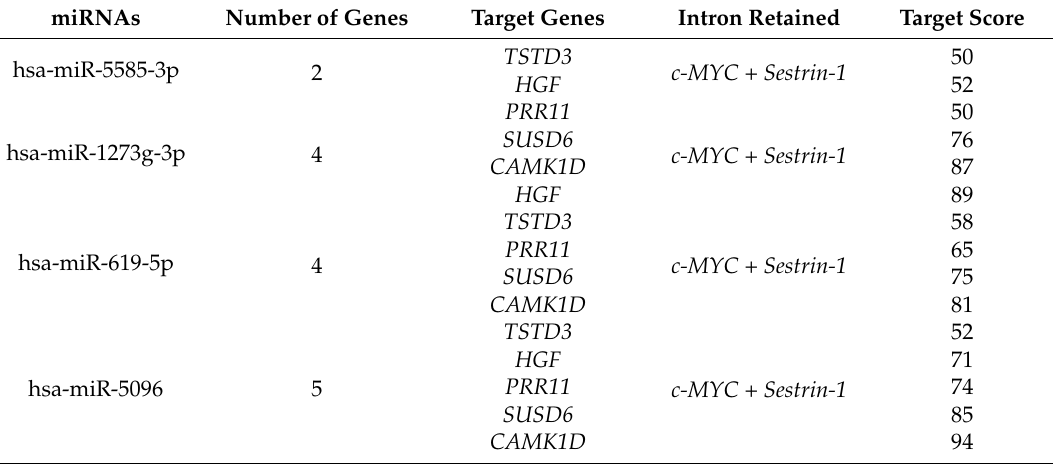
Table 1. Collection of miRNA species that are likely produced by both c-MYC (2/3) and Sestrin-1 (9/10) retained introns, and can simultaneously downregulate the same group of target transcripts. Name of human miRNA molecule, number of miRNA target genes (transcripts), name (symbol) of target gene, name (symbol) of gene undergoing intron retention, and target score (success level of miRNA complementary binding to target transcript sequence) are shown (also, see Figure 4 and Table S2). hsa: Homo